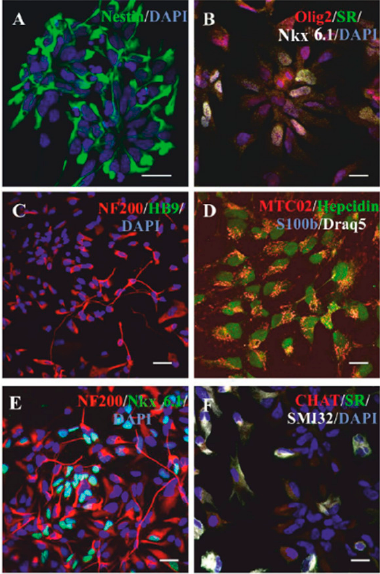
Figure 1. Neural progenitors derived from induced pluripotent cells (NP-iPS) in vitro characteristics. Immunostaining shows that NP-iPS cultures that were used for transplantation at the starting point of differentiation (contained nestin- ( A ), Olig2-, serotonin- (SR), and Nkx6.1-positive cells ( B ). At day 0, NP-iPS cultures were NF200-positive, but they did not express a motoneuron (MN)-specific marker HB9 ( C ). All NP-iPS were positively stained with human mitochondria (MTC02) and expressed a hepcidin ( D ), but they were S100 β -negative ( D ). NF200 and Nkx6.1 co-staining revealed equal proportions of Nkx6.1-positive and Nkx6.1-negative cells in cultures ( E ). NP-IPS cultures did not contain acetylcholine transferase (CHAT)-positive cells, and only few cells were SMI32-positive ( F ). Scale bars = 20 µm.